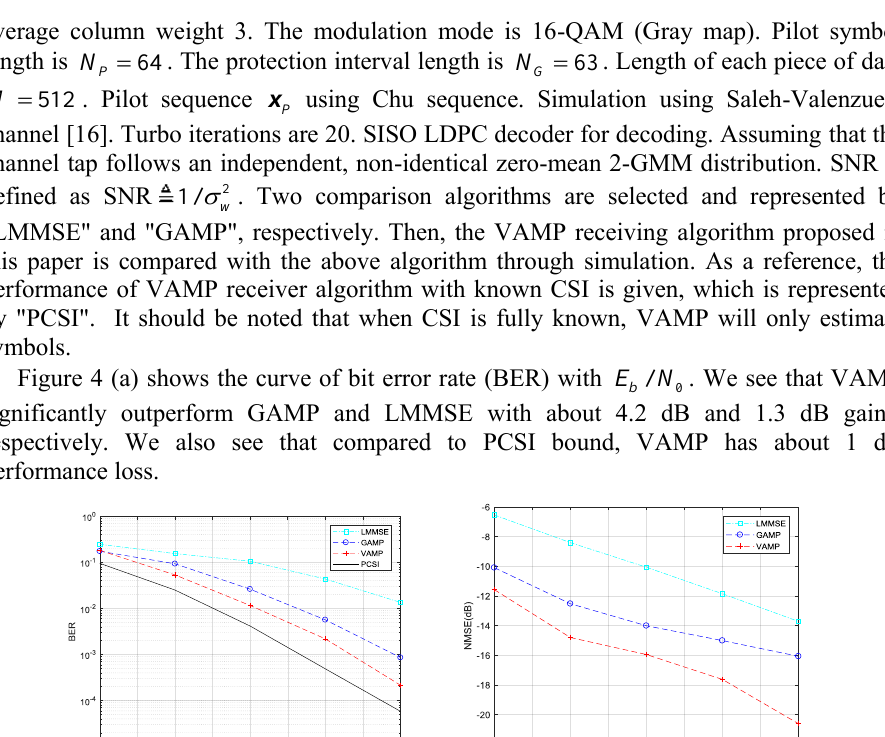
/ E N for different receiving algorithms under UW 0 b